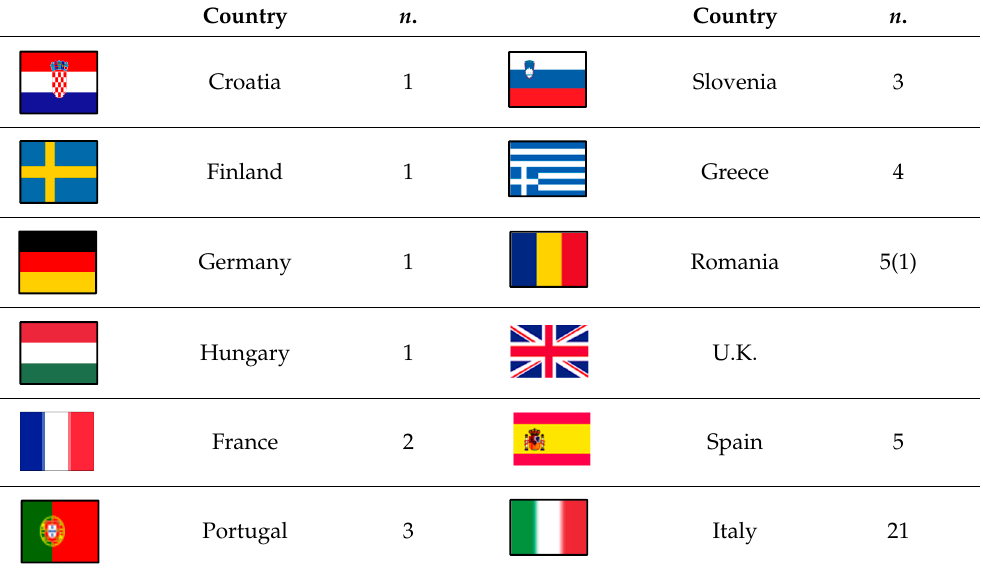
Table 2. Specific conservation plans (LIFE+) for the large carnivores in EU countries (up to 2018). Country n .